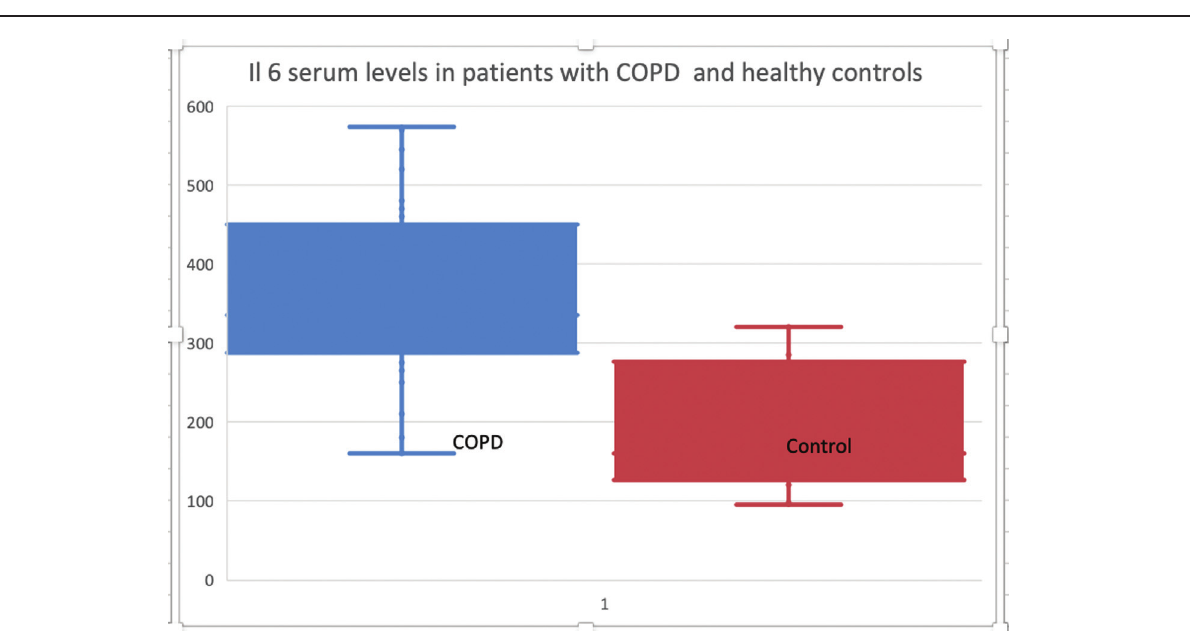
Serum levels of IL-6 were significantly higher in patients with COPD compared with healthy controls. COPD, chronic obstructive pulmonary disease; IL-6, interleukin 6.